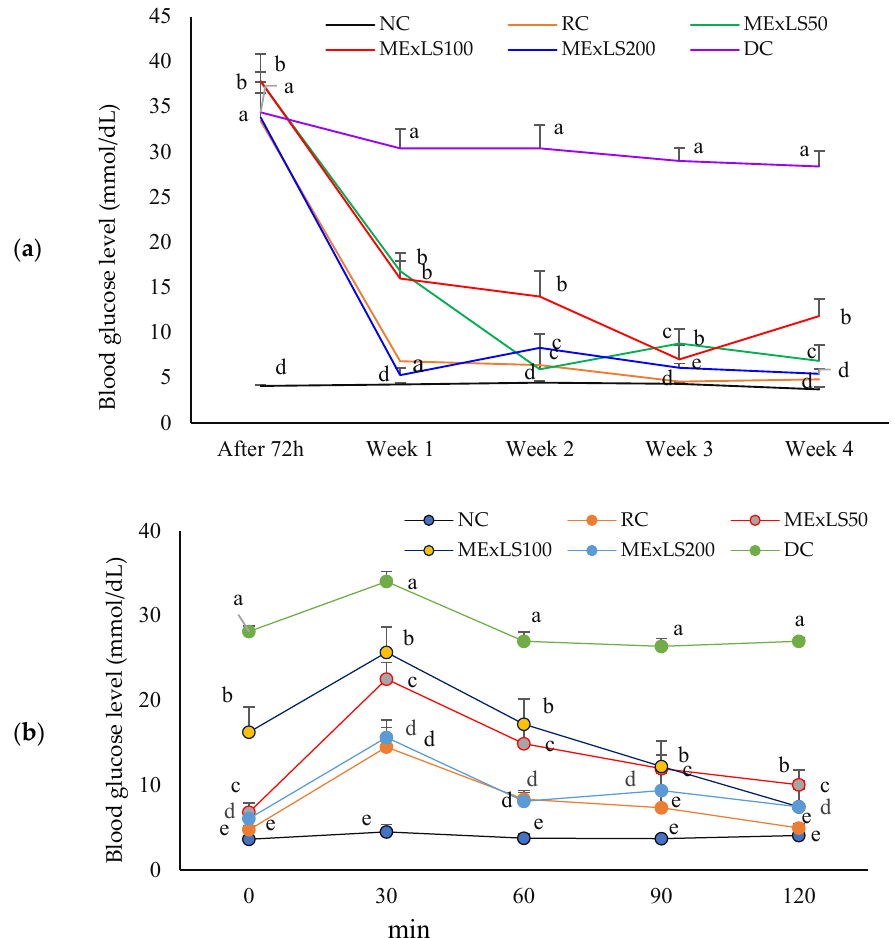
Figure 4. ( a ) Weekly blood glucose level for ME X LS intervention. ( b ) A four-week oral glucose tolerance test was conducted on albino rats under specific pressure and temperature conditions ( n = 5). Mean ± SEM are used to express data. Data were analyzed by one way analysis of variance (ANOVA) using the statistical software SPSS followed by Tukey’s Post Hoc test. p < 0.05 was consideration as the level of significance. The superscript letter a-e on the lines indicate the significant differences between and among the groups.